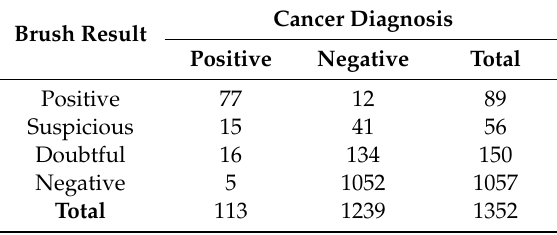
Table 5. Results of brush biopsy versus final